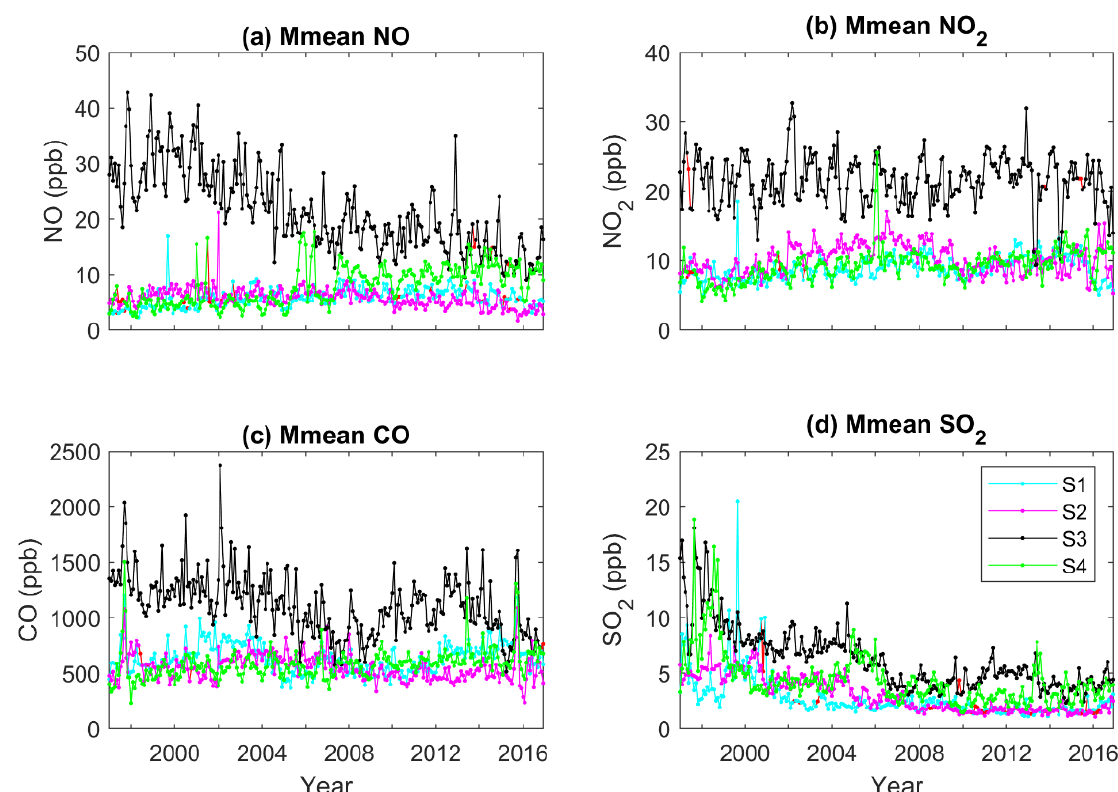
Figure 6. Time series of Mmean for NO ( a ), NO 2 ( b ), CO ( c ), and SO 2 ( d ). Data points in red are missing observations that have been filled with computed values.